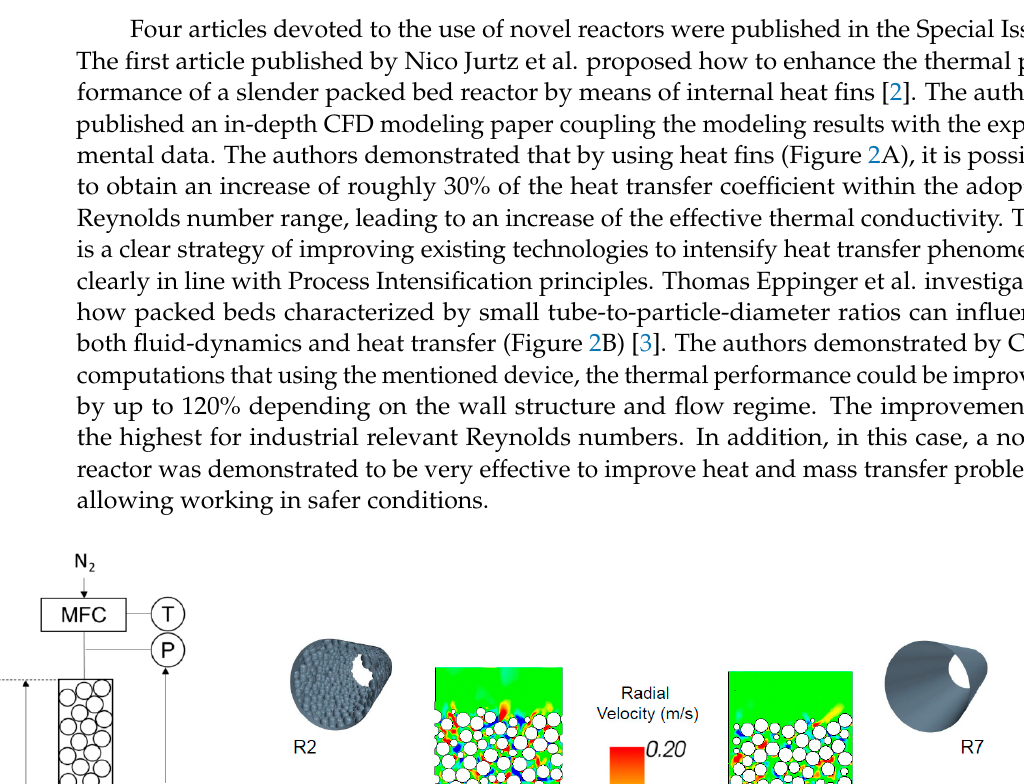
Figure 1. Statistical information related to the Special Issue “Process Intensification in Chemical Reaction Engineering”. ( A ) Number of publications per year related to Process Intensification (Scopus Database). ( B ) Distribution of papers per macro area.